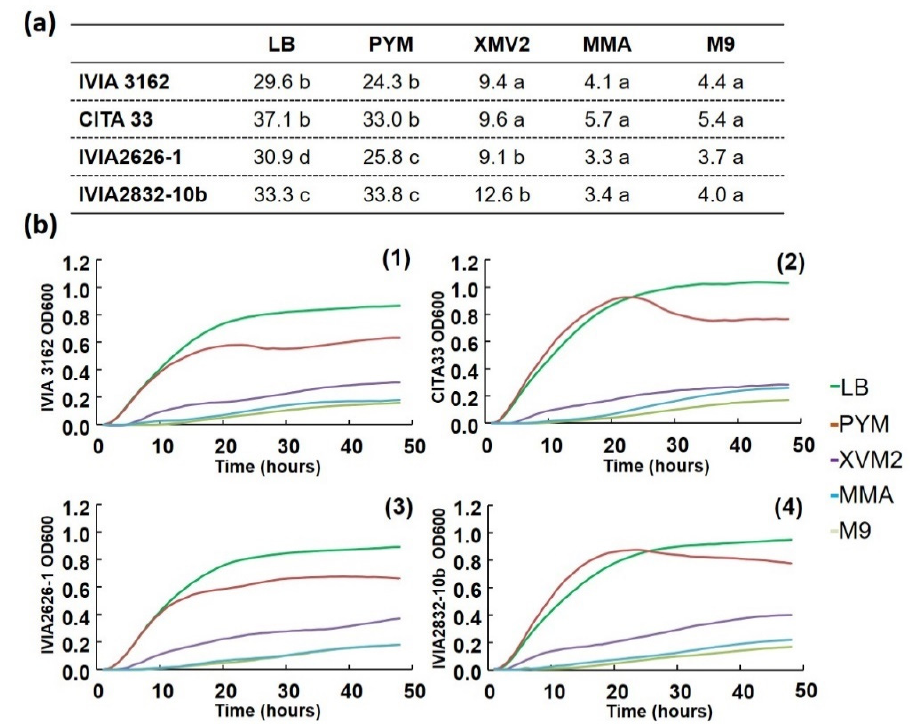
Figure 1. ( a ) Areas under growth curves (OD 600 ) of Xap strains on: LB, PYM, MMA, XVM2 and M9 media. The table shows the average of four replicates in each two assays. Means with the same letter in a row do not differ significantly according to Student-Newman-Keuls test ( p = 0.05). ( b ) Measure of bacterial growth by absorbance at 600 nm. Media assayed: LB, PYM, MMA, XVM2 and M9. Xap strains: IVIA 3162 (1), CITA 33 (2), IVIA 2626-1 (3) and IVIA 2832-10b (4).